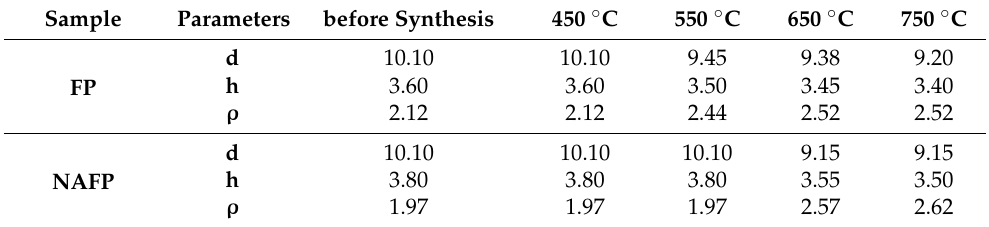
Table 2. Geometrical parameters of samples NAFP and FP matrices at different synthesis tempera- tures, where d—diameter of tablet (mm), h—height of tablet (mm), ρ —density (g/cm 3